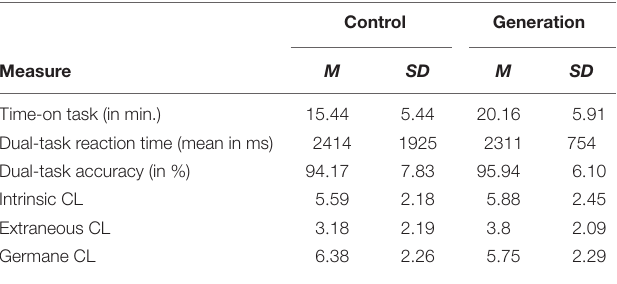
TABLE 2 | Mean scores and standard deviations of learning